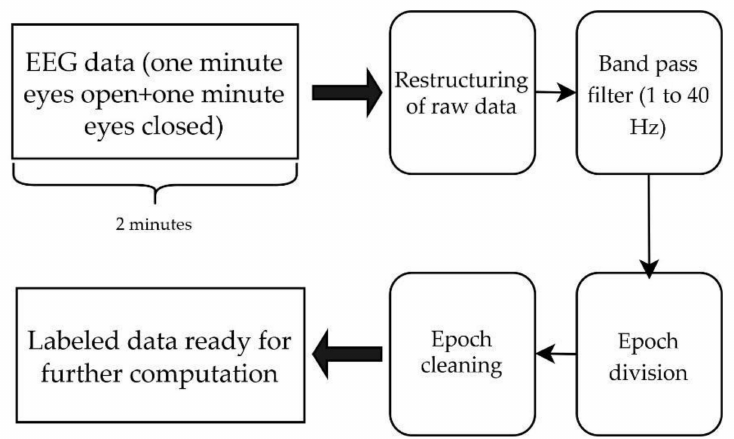
Figure 6. EEG data pre-processing pipeline. EEG data consisted of 2 min data of eyes-open and eyes-closed condition. The raw data were restructured with labels and then bandpass filtered, and split into epochs. Epochs were cleaned according to epoch acceptance criteria to have labeled data which were ready for further